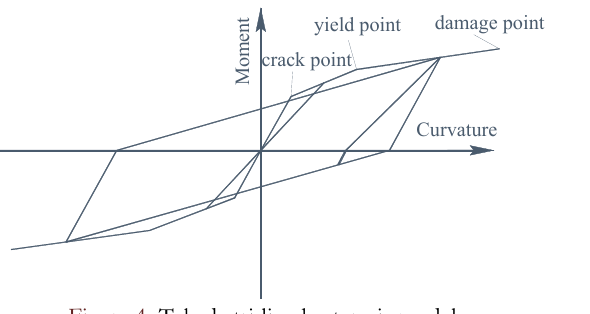
Figure 4: Takeda tri-line hysteresis model.